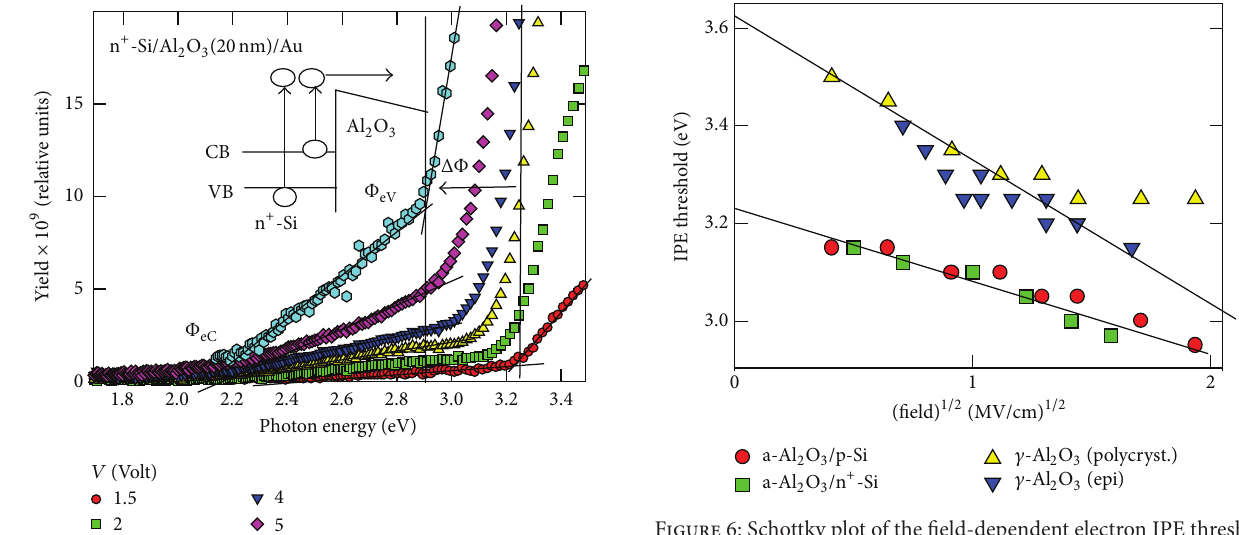
Figure 6: Schottky plot of the field-dependent electron IPE thresh- olds as measured on samples with different types of insulating Al 2 O 3 grown on silicon crystal substrate. Lines illustrate linear extrapolation used to infer the zero-field energy barrier between the top of the Si VB and the bottom of the Al 2 O 3 and eC